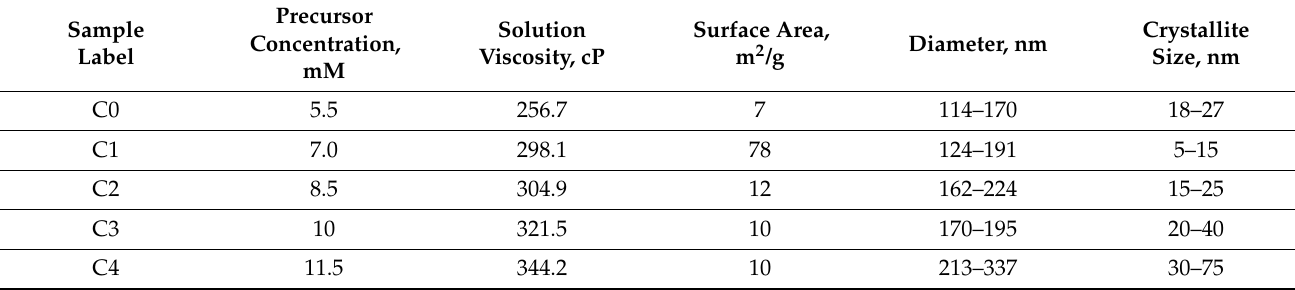
Table 3. Properties of the solution for electrospinning and the resulting nanostructures after annealing.